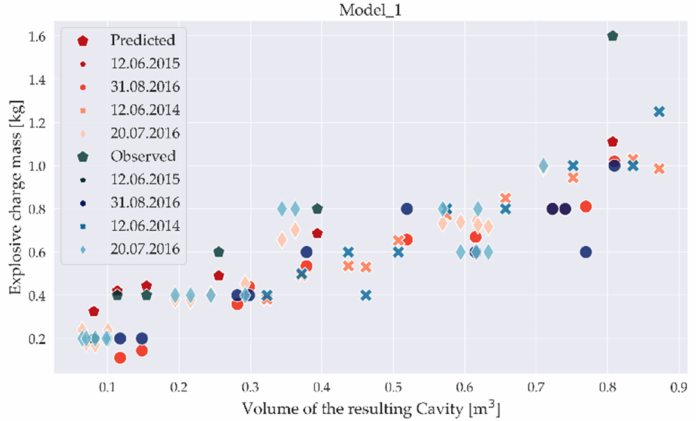
Figure 8. Model_1—Explosive charge mass vs. volume of resulting borehole cavity.